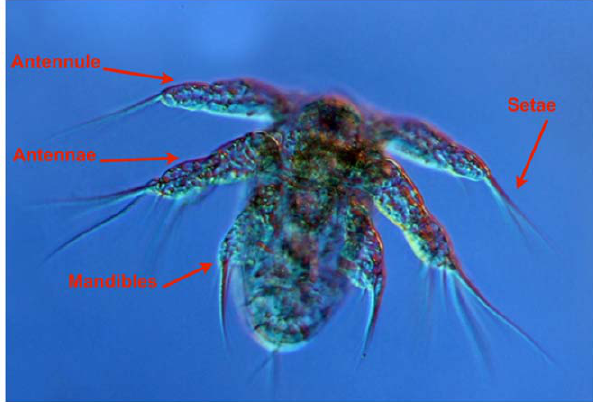
Figure 1. Appendages analyzed. (Acartia tonsa nauplius showed as example): antennules (A1), antennae (A2) and mandibles